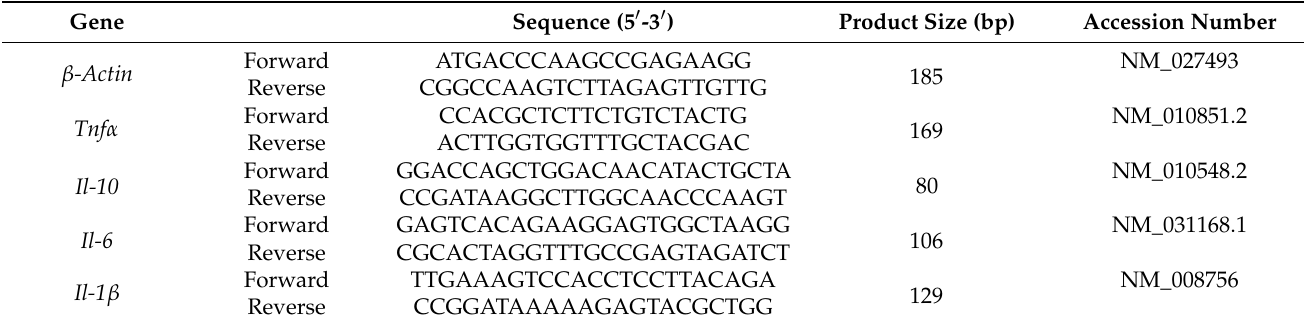
Table 1. Primers used for